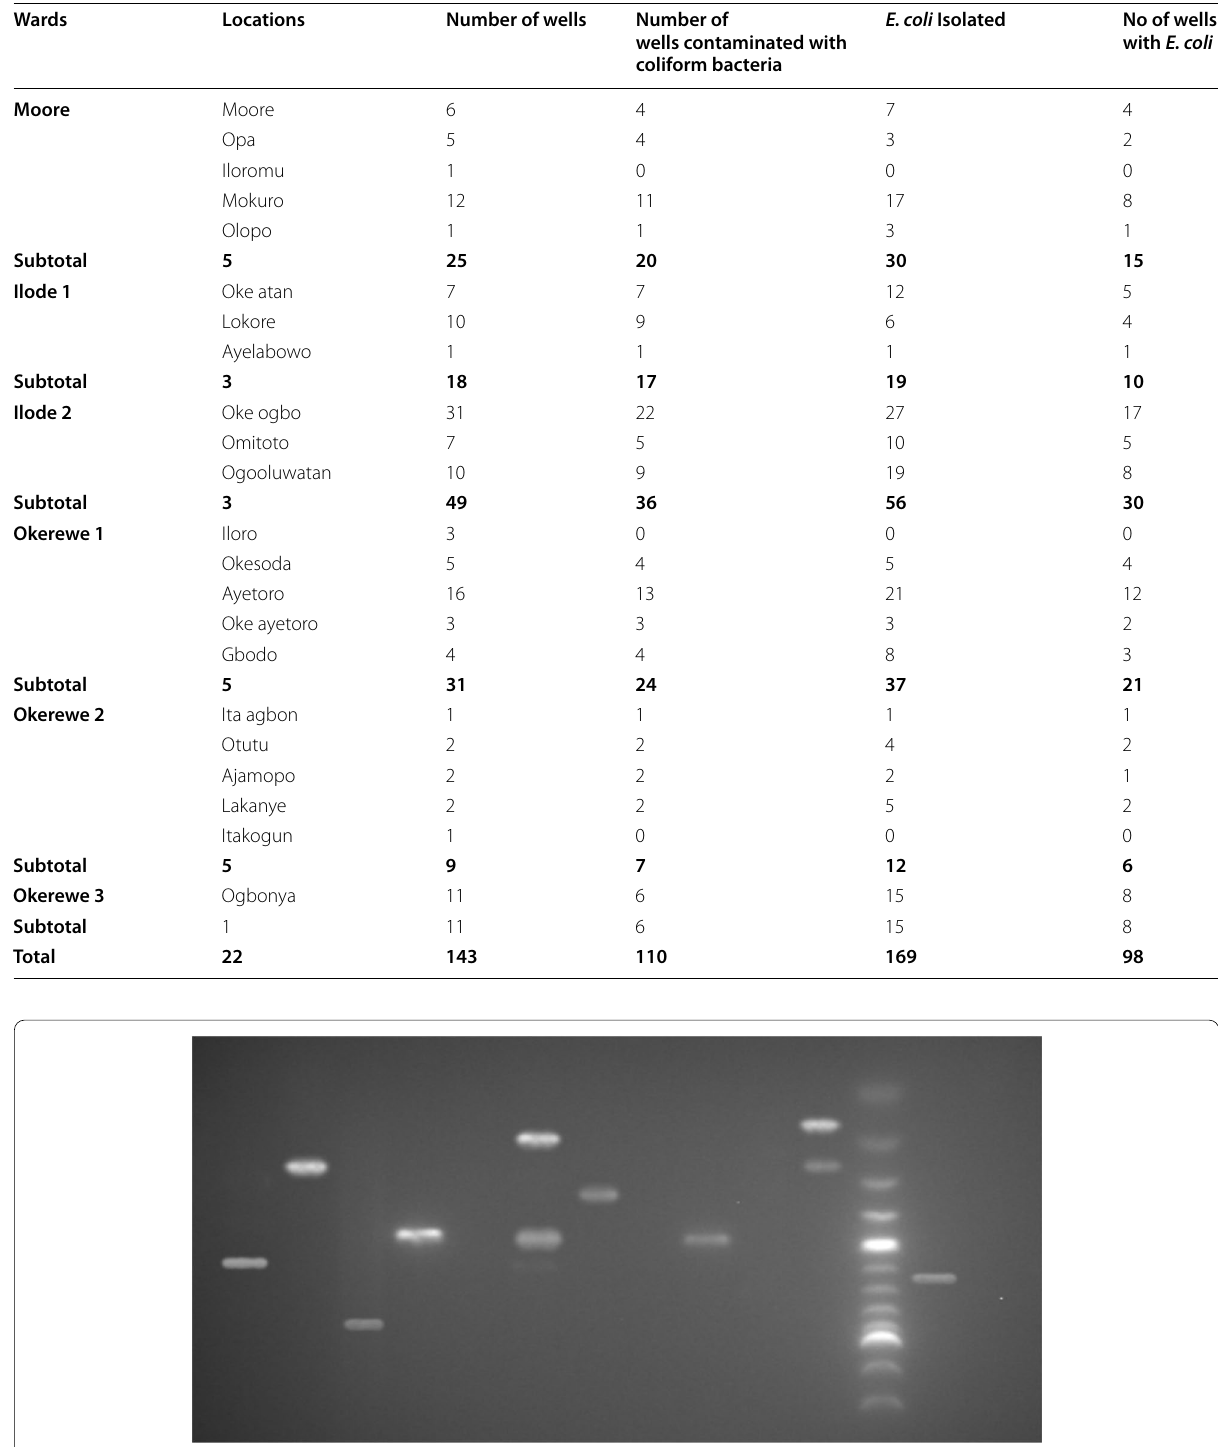
Fig. 2 A representative gel picture showing diarrhoeagenic virulence genes of water isolates. Lane 1: Water (Negative); Lane 2: E. coli 042 (CVD432-630bp); Lane L: 100bp ladder; Lane 3: E. coli EDL 933 (stx1-180bp, stx2-255bp); Lane 4: E. coli ; Lane 5: E. coli H10407 (LT-450bp); Lane 6: E. coli; Lane 7: E. coli E2348 (bfp-326bp); Lane 8: E. coli H10407 (ST-190bp and LT-450bp): Lane 9: E. coli; Lane 10: E. coli (LT-450bp); Lane 11: E. coli (eae-917bp); Lane 12: E. coli (stx2-255bp); Lane 13: E. coli E137